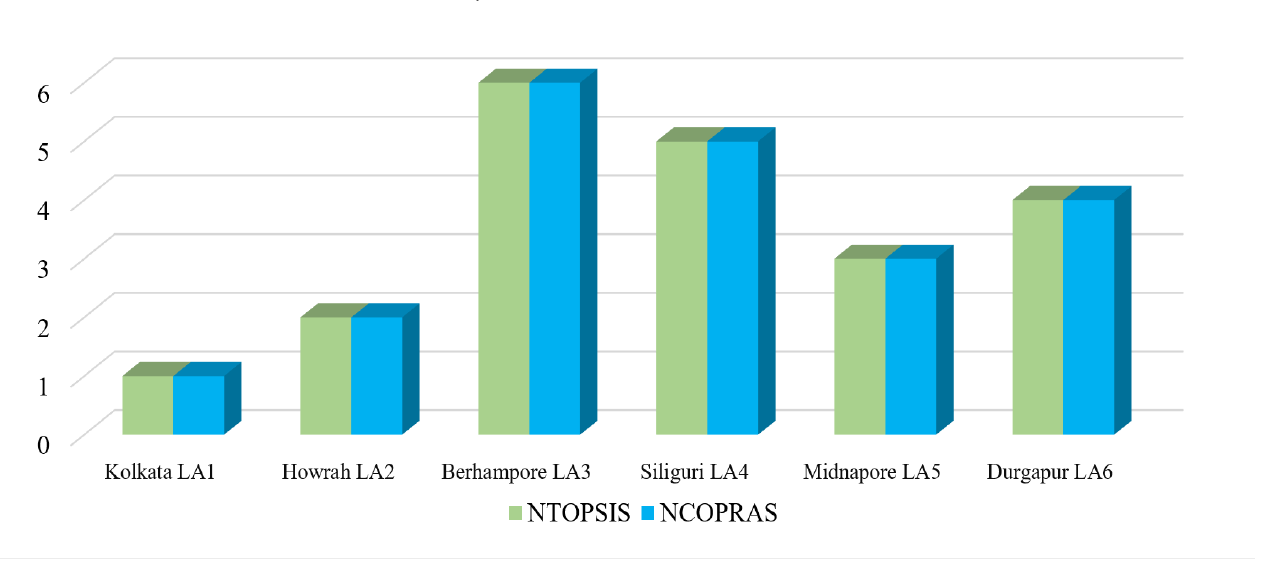
Figure 6. Comparative ranking diagram between NTOPSIS & NCOPRAS